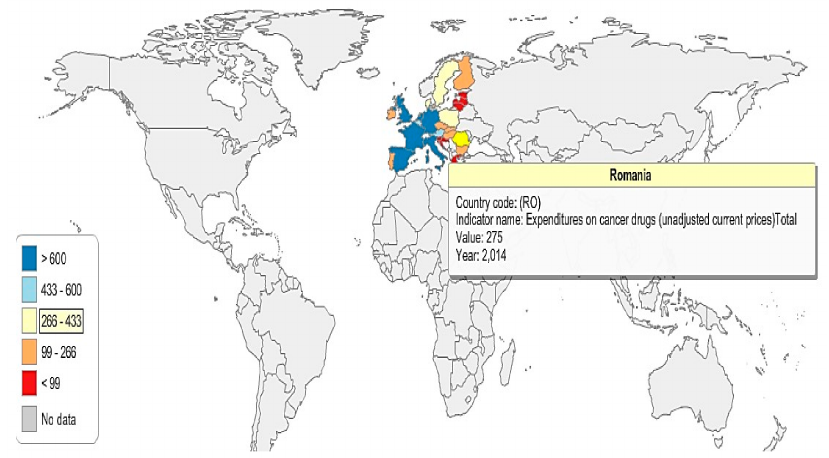
Figure 5. Anti-cancer drug expenditure map, Romania and the 26 EU countries,